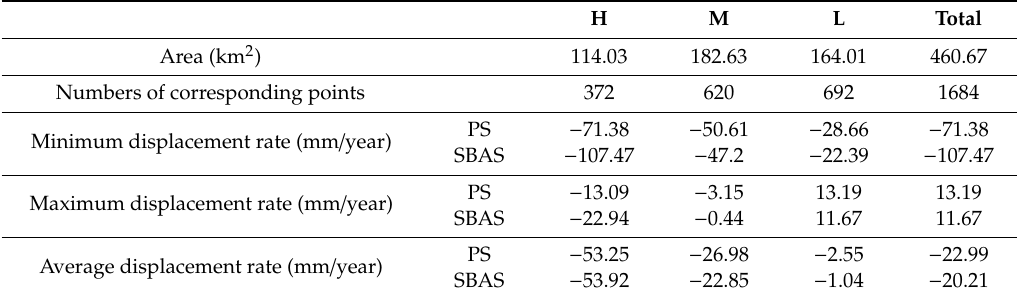
Table 3. Comparison of corresponding points in the study area.